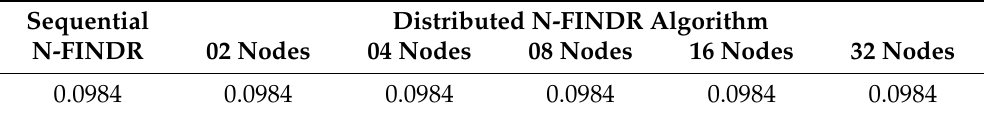
Table 2. Accuracy ( φ E ) obtained with sequential processing of the N-FINDR algorithm, and with the proposed distributed version, over different cluster configurations on the Cuprite